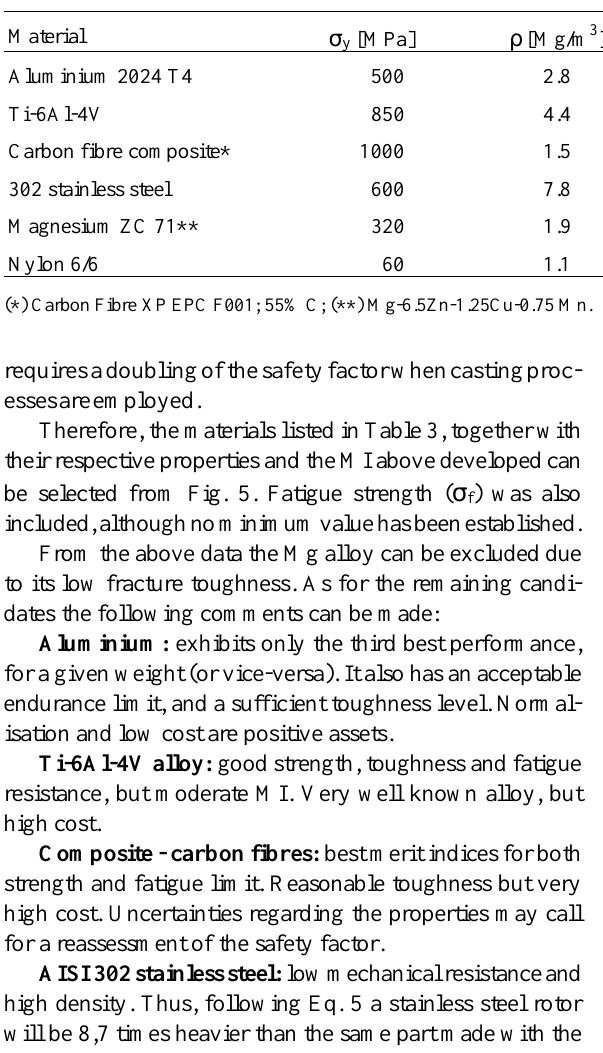
Table 3. Candidate materials, respective properties and